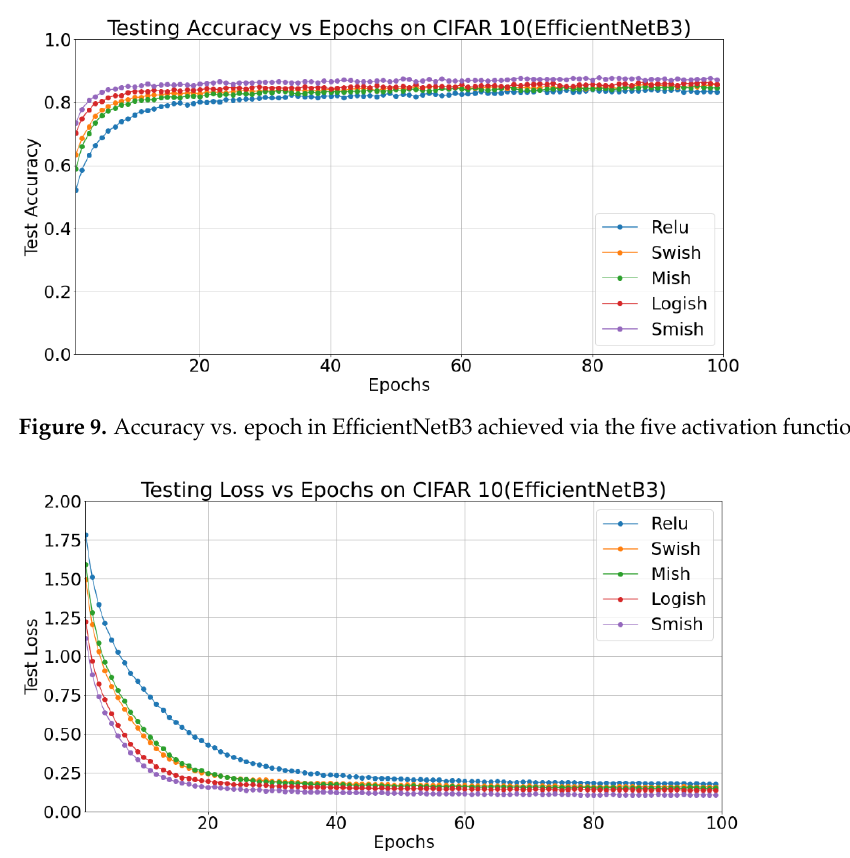
Figure 10. Loss vs. epochs in EfficientNetB3 achieved via the five activation functions on CIFAR10.